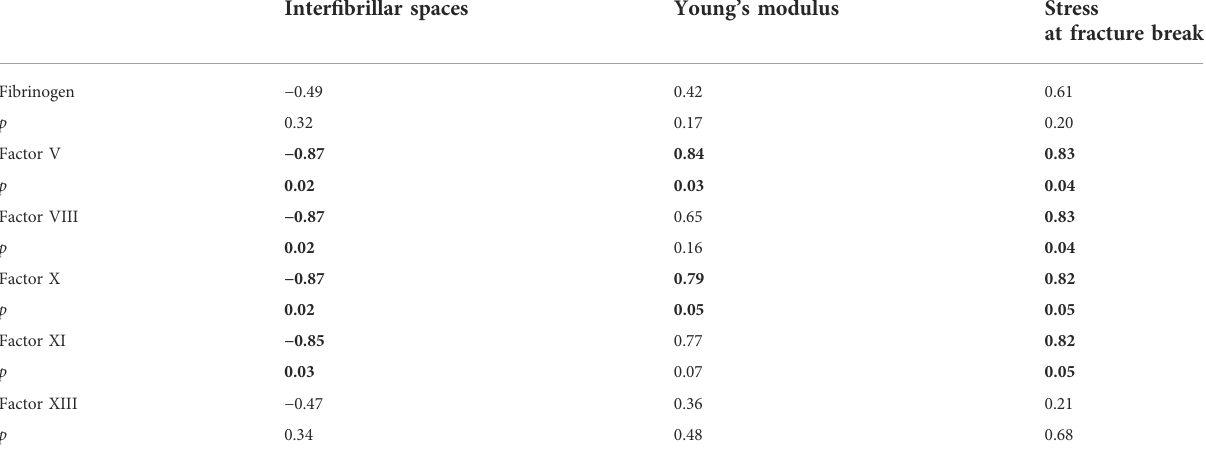
TABLE 1 Correlation matrix between structural and biomechanical properties and coagulation